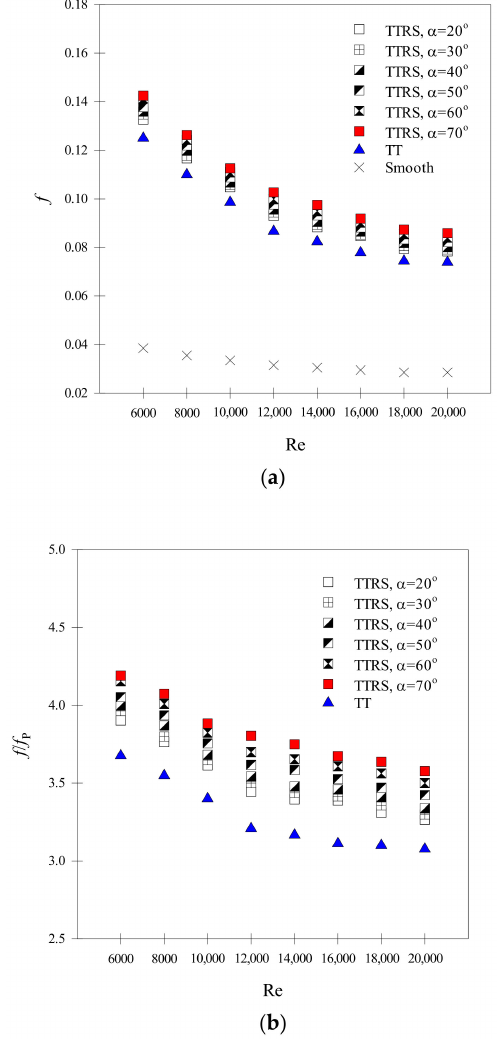
Figure 6. Effect of the twisted tapes in rib and sawtooth form vortex generator (TTRS) at varying sawtooth angles ( α ) on the friction factor. ( a ) f ( b ) f/f p .